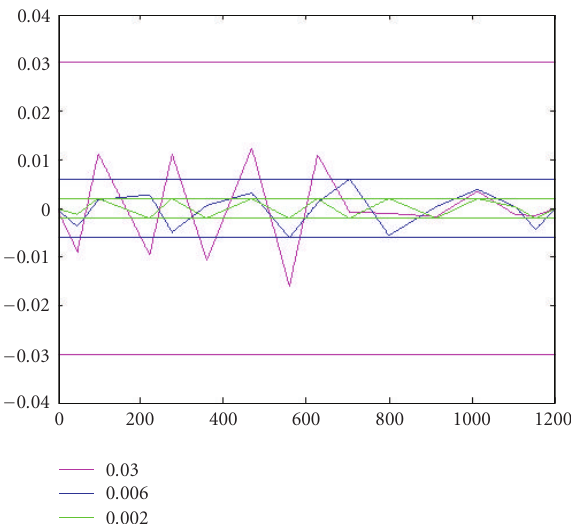
Figure 8: The values of the global acceleration constraints for the results shown in Figures 6(a) (pink), 6(b) (blue), 6(c) (green), and Figure 7. The horizontal axis gives time for the speech utterance. The horizontal lines give the limits of the acceleration constraint in each case.